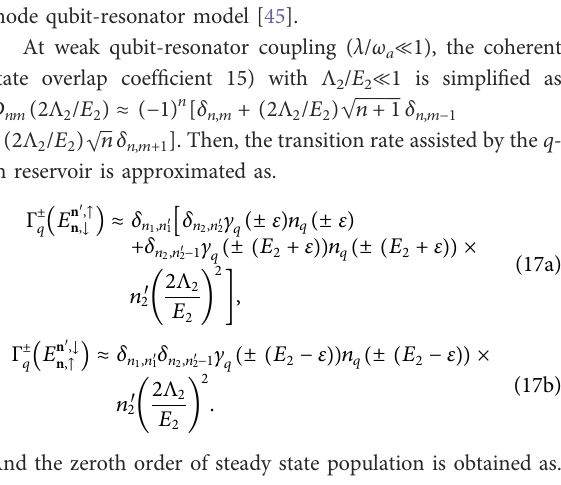
(cid:5) √ λ . Hence, the bosonic eigen- 2